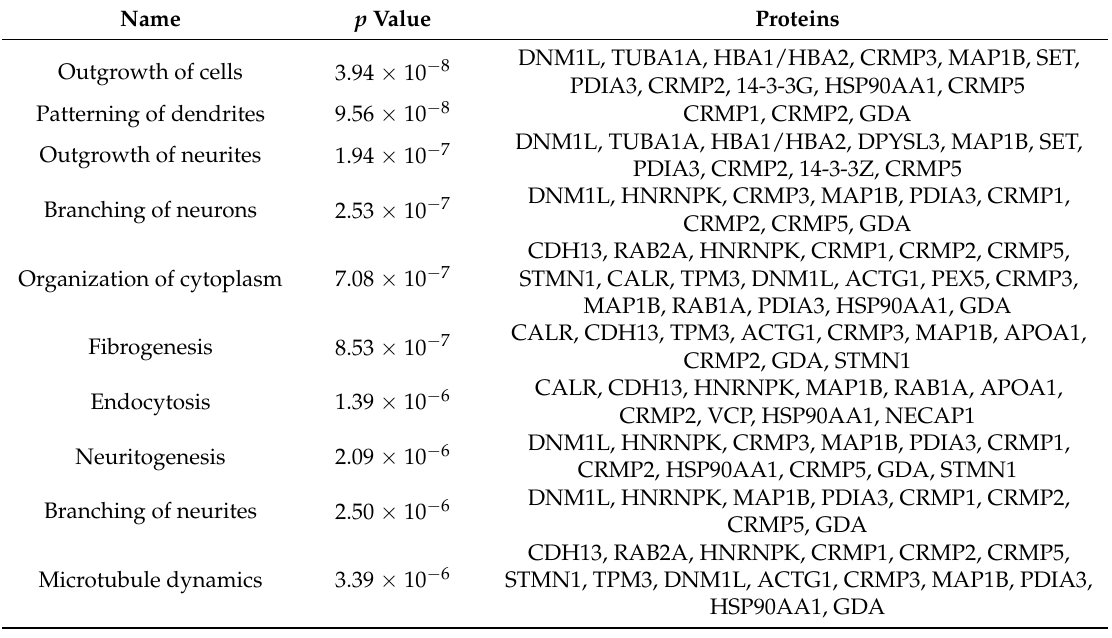
Table 3. Ingenuity Top 10 molecular and cellular